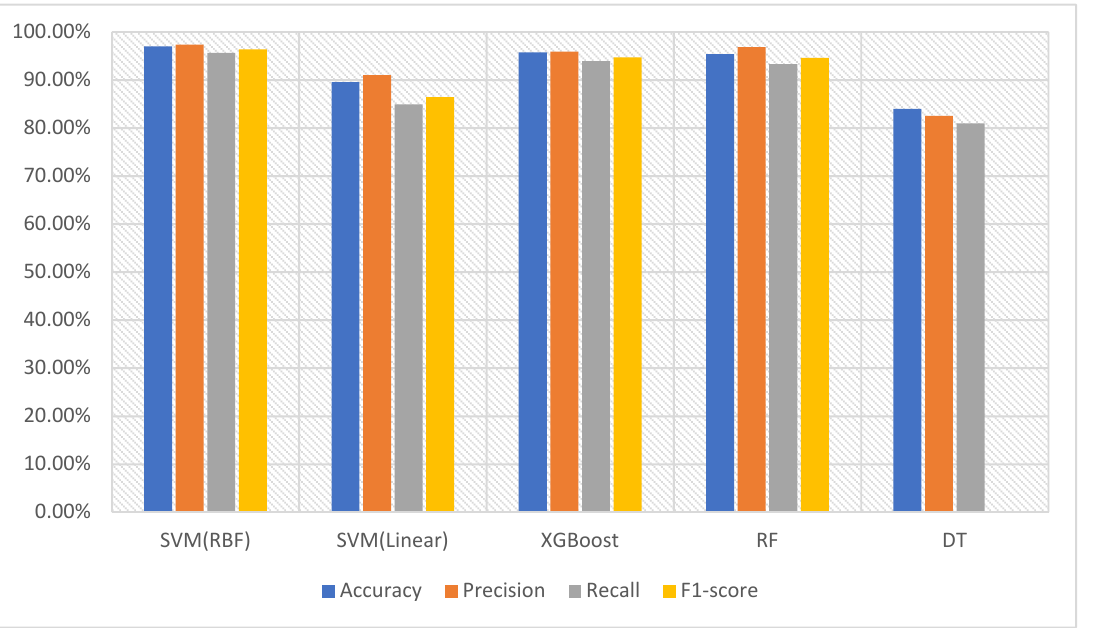
Figure 13. Comparison of the results of the machine learning classifiers on version 2 of the dataset.